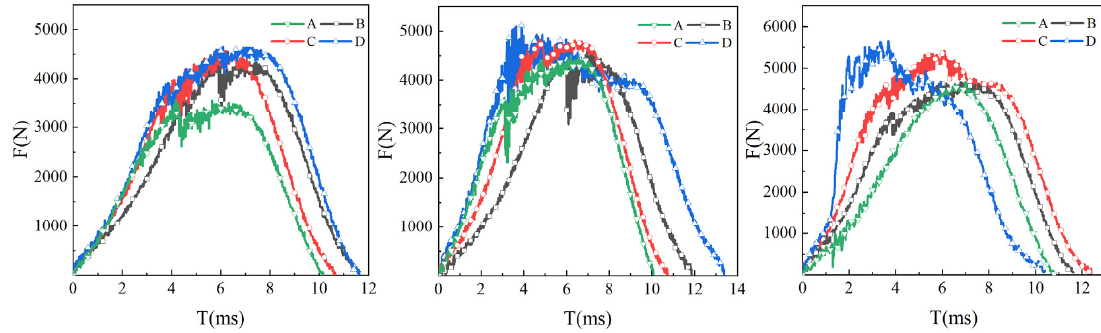
Figure 15. Impact load curve of laminate.